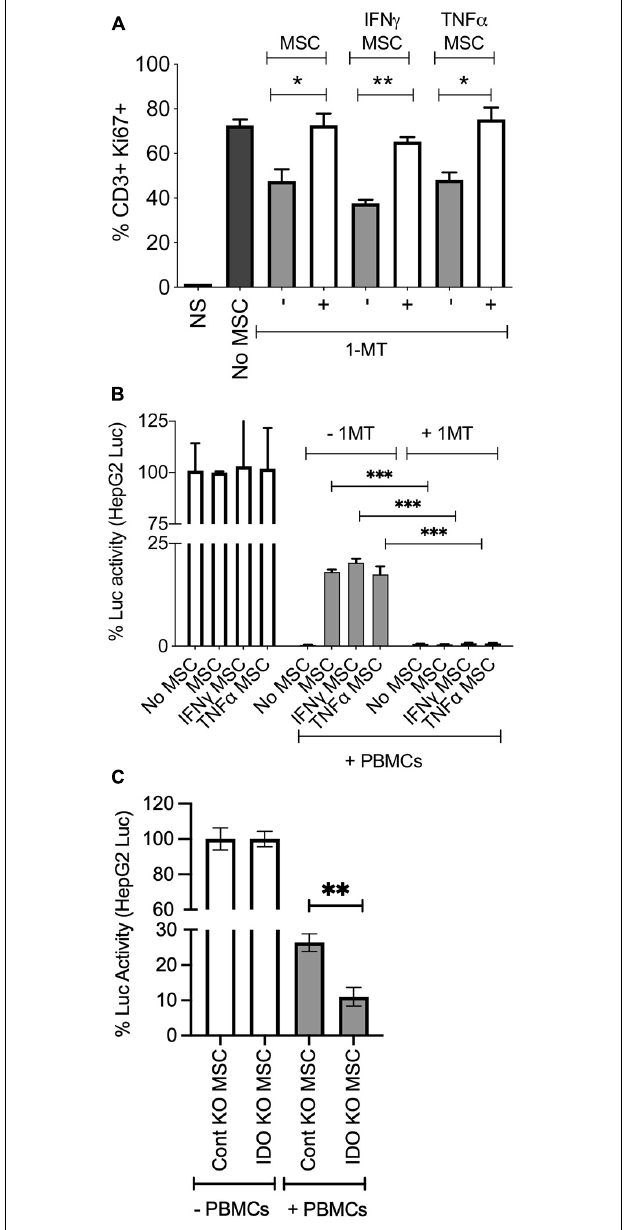
FIGURE 6 | MSCs protect HepG2 cells through indoleamine 2,3 dioxygenase mechanism. ± IFN γ or ± TNF α treated MSCs were cultured with HepG2-Luc cells and SEB activated PBMCs with and without 1-MT (1 mM). After 3 days, (A) T cell proliferation was measured by Ki67 intracellular staining. Two tailed unpaired t test analysis was performed through prism software to get the p values. (B) Luciferase activity was measured to detect the survival of HepG2 cells on the third day. Two-way analysis of variance (ANOVA) multiple-comparison test was performed between the independent conditions using Prism Software. (C) Control or IDO siRNA transfected MSCs were cultured with HepG2-Luc cells in the presence and absence of SEB stimulated PBMCs. Luciferase activity was measured to detect the survival of HepG2 cells on the third day. Two tailed unpaired t test analysis was performed through prism software to get the p values. * P ≤ 0.05, ** P ≤ 0.01, *** P ≤ 0.001. Representative results are shown from two independent